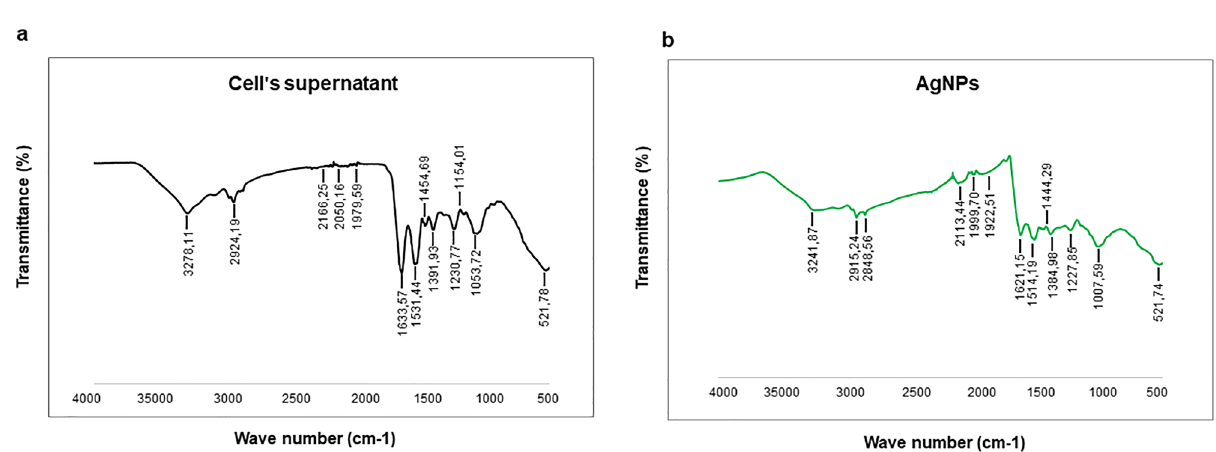
Figure 5. Fourier transform-infrared spectroscopy spectra of ( a ) Cell’s supernatant and ( b )